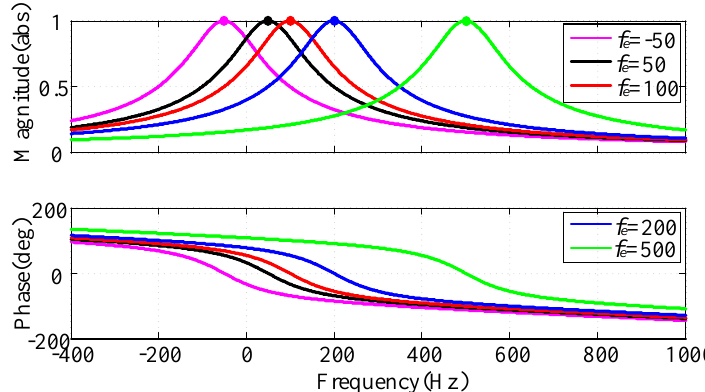
Figure 9. Bode plot of current closed-loop with delay compensation with D-PCI